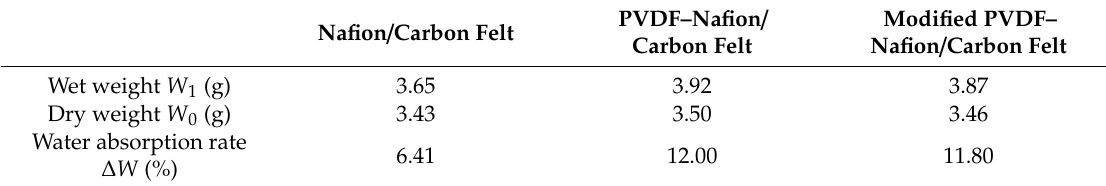
Table 2. Water absorption rate of di ff erent membranes.